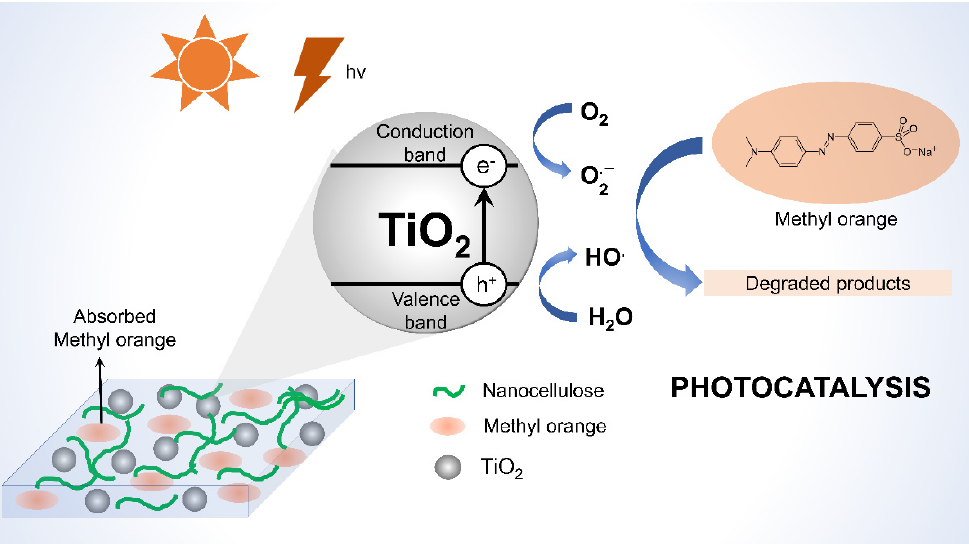
Figure 13. Mechanism of photocatalytic degradation of methylene blue by TiO 2 /GO/cellulose mem ‐ brane.